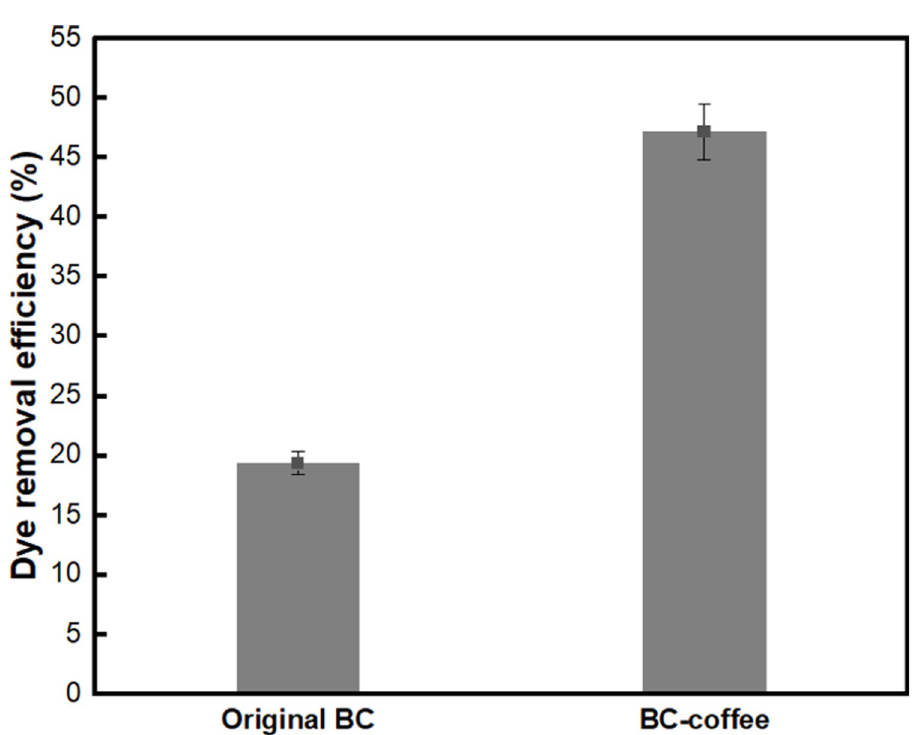
Fig 13. Dye adsorption rate (%) of original BC and BC-COF bio-leather (Extraction conditions: Liquor ratio of 1:10 (w/v), coffee at an amount of 200 wt% BC, 90˚C, 1 h; dyeing conditions: Fabric-to-liquor ratio of 1:10 (w/v), 70˚C, 30 min, meta-mordanting with 1% of FeSO 4 ; dye adsorption conditions: 50 mg/L of methylene blue solution with a fabric-to-liquor ratio of 1:200 (w/v), pH 6, 25˚C, 30 min).